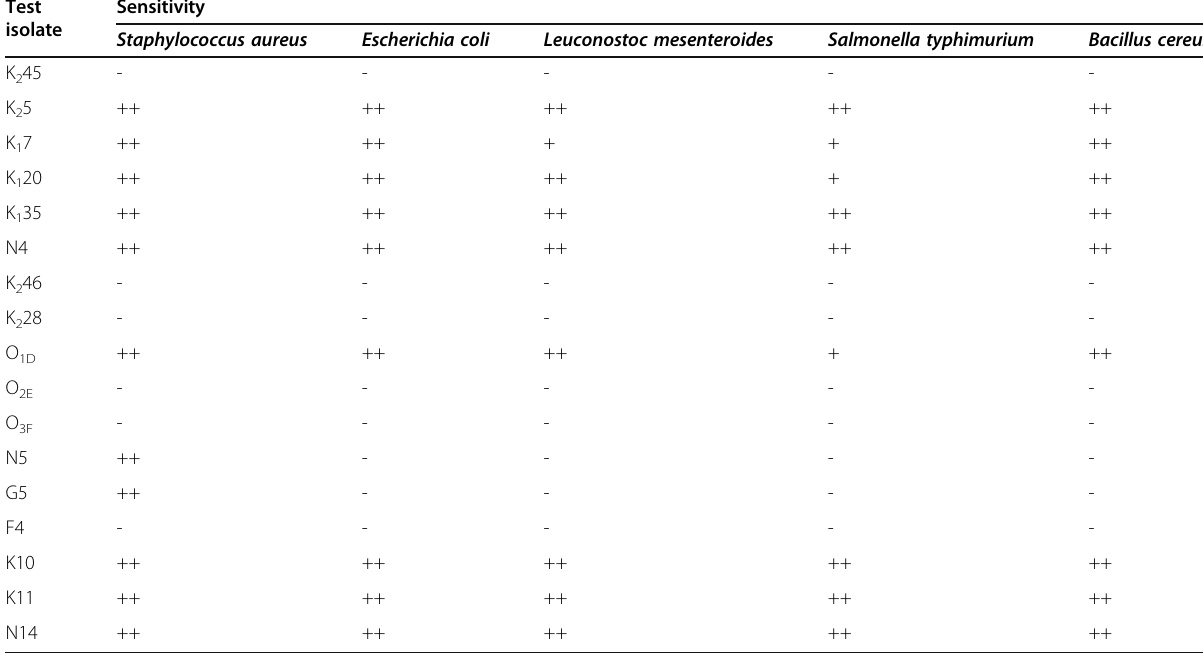
Table 2 Inhibitory activity of selected lactic acid bacteria strains against bacterial indicator strains after eliminating effect of organic acid and H 2 O 2 by using agar well diffusion method Test